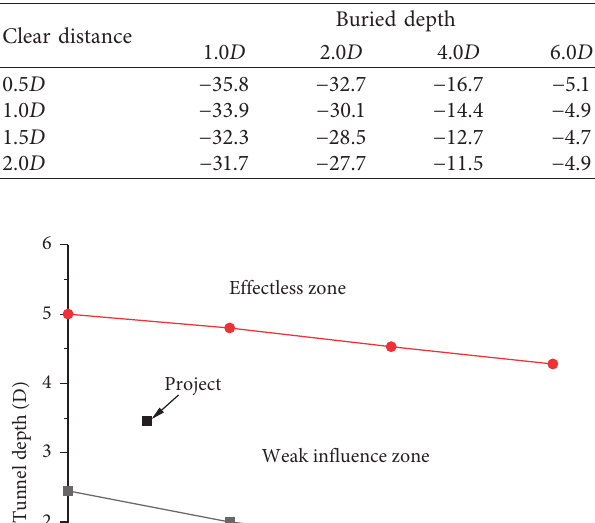
Table 11: Maximum settlement on the surface of each working condition (unit: